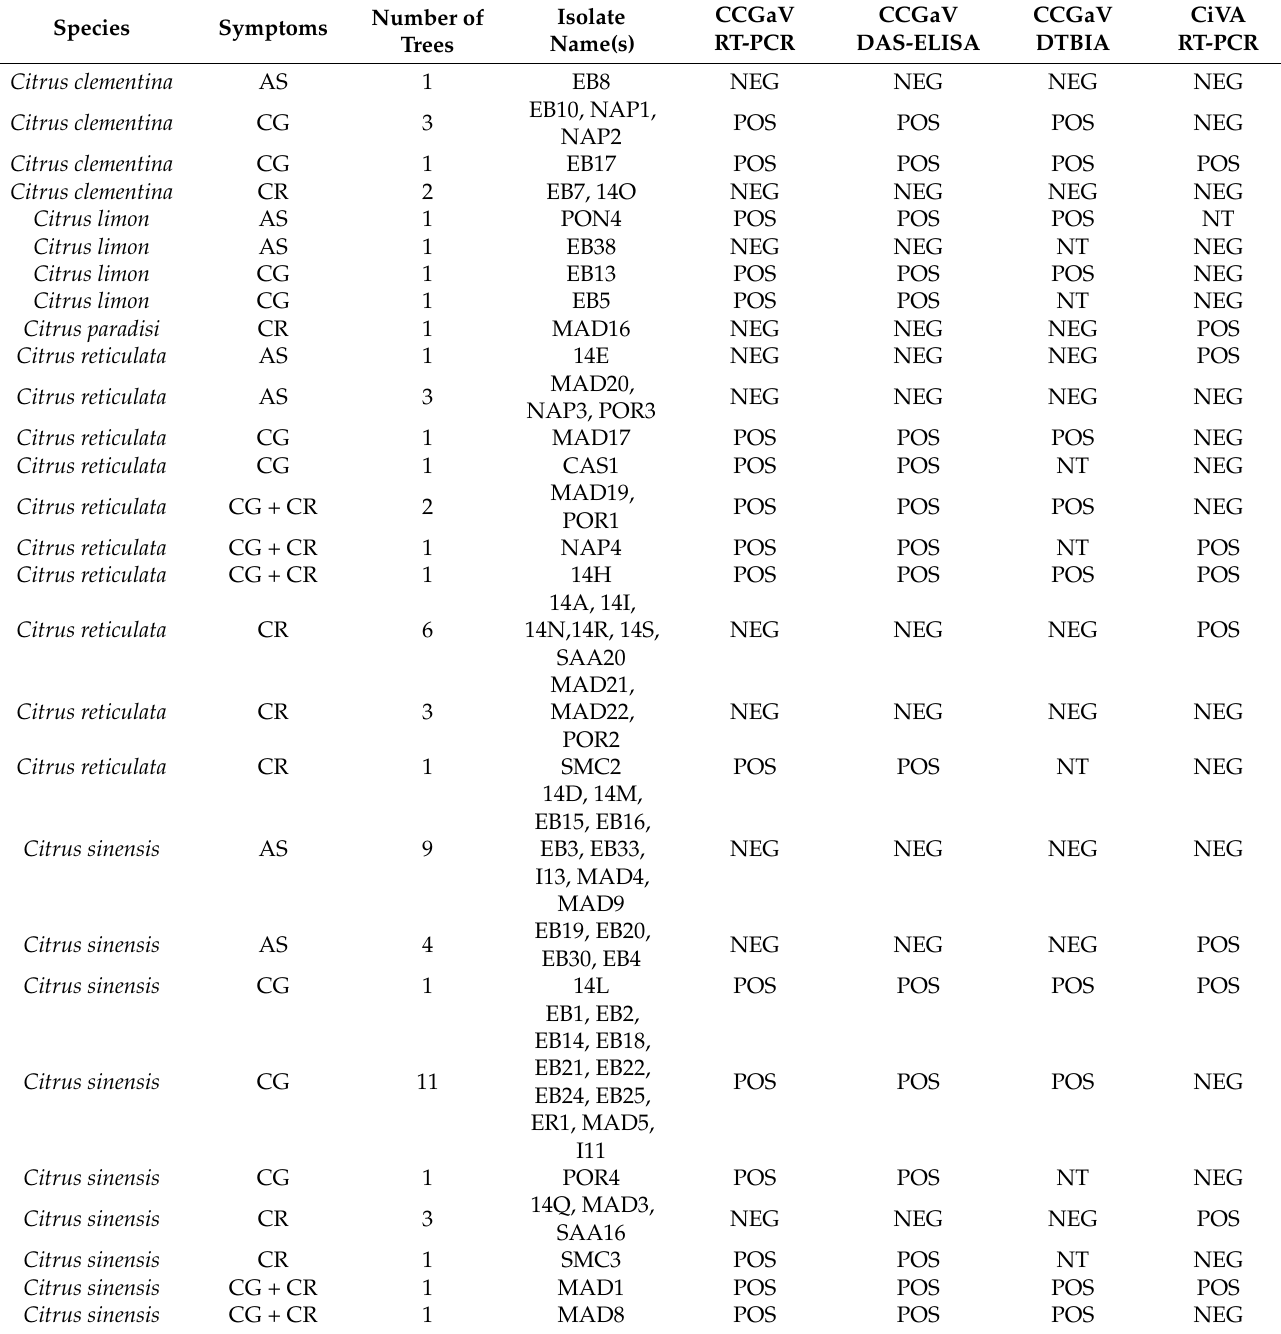
Table 1. Results of citrus field survey for detection of CCGaV, using different detection methods, and CiVA using RT-PCR.